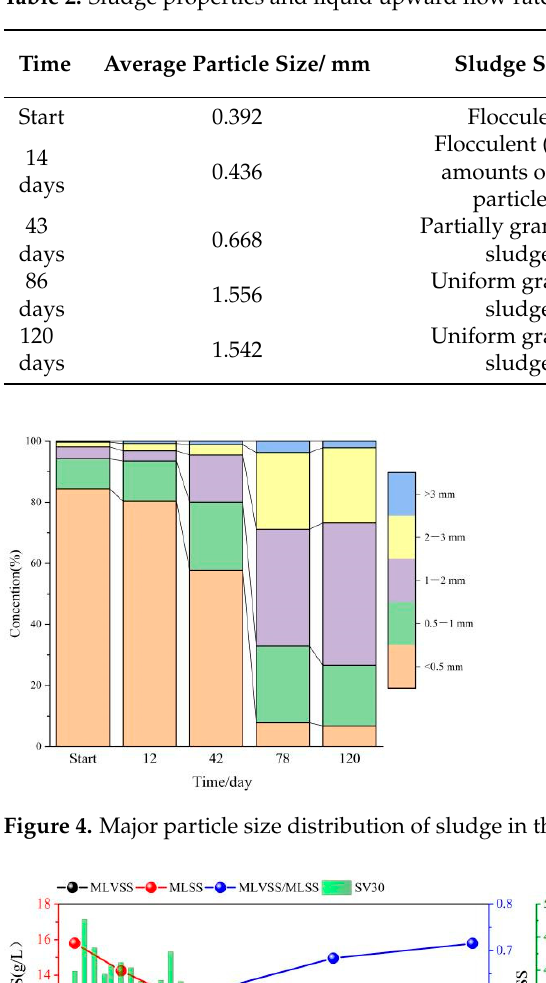
Figure 5. Sludge microbial content and sedimentation performance.